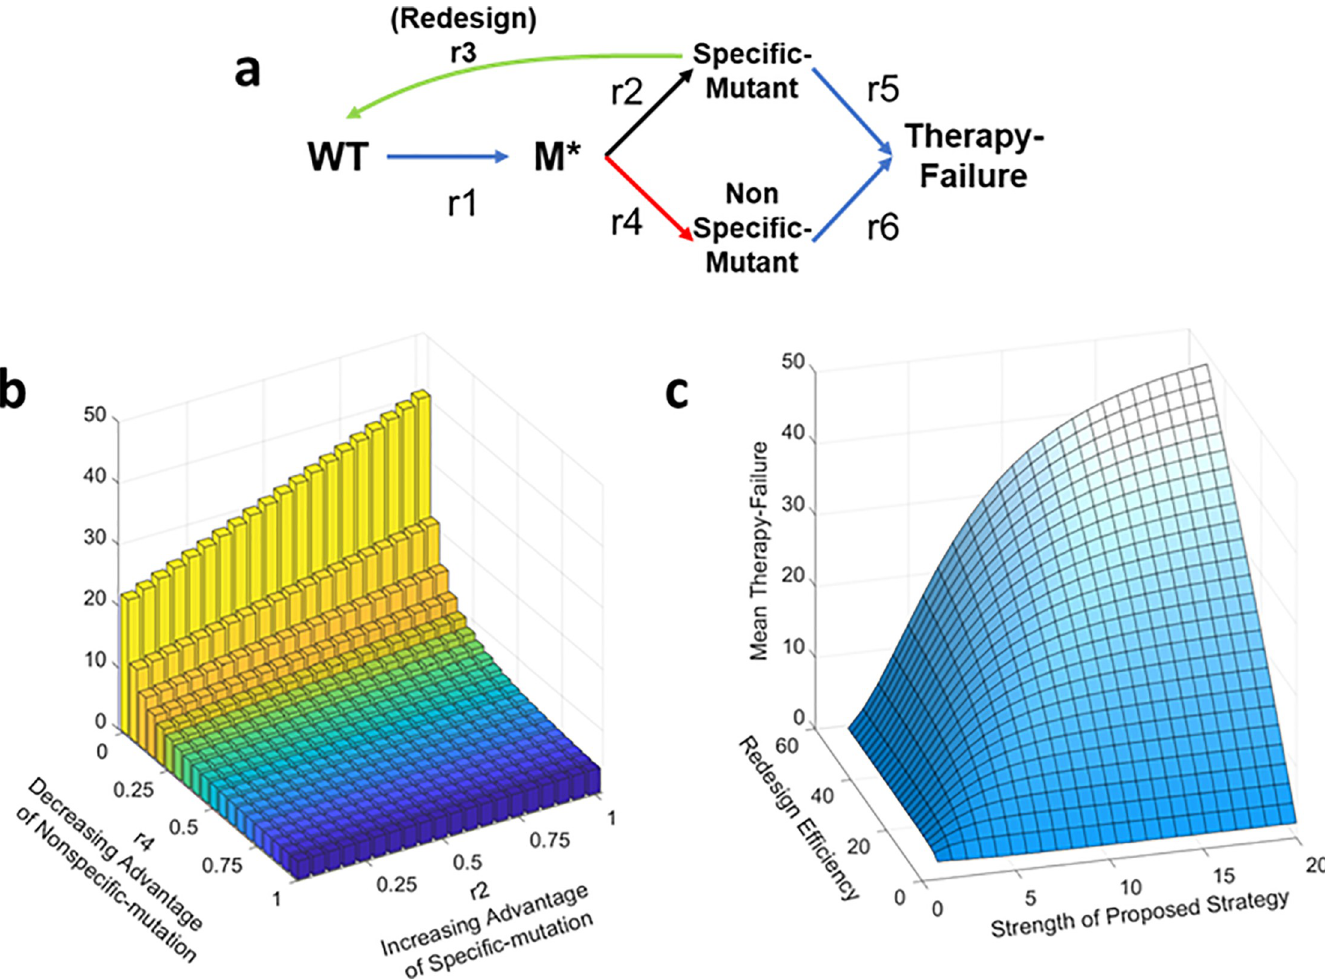
Fig 5. Simple analytical model: This figure shows a simple continuous-time markov model that illustrates our concept. A. Five states are considered, vulnerable (originally wild type), Mixed state of WT majority and its mutants (M � ), resistant to antisense (specific mutant) resistant to delivery vehicle (nonspecific mutant), resistant to both antisense and delivery vehicle (therapy-failure). Rate coefficients for transitions are as shown. B. Plot of mean therapy failure time for r2 and r4. The plotted surface is associated with equation B in S1 File). r1, r5, r6 are taken as 1, since they are proportional to mutation rate, and we scale the mutation rate to be 1. C. Plot of mean therapy failure time for strength of proposed strategy (r2 maximized over r4) and redesign efficiency. r2 was parameterized by PS (proposed strategy). r4 was parameterized by 1/PS. R3 was parameterized by RE (Redesign efficiency). The plotted surface is associated with equation C in S1